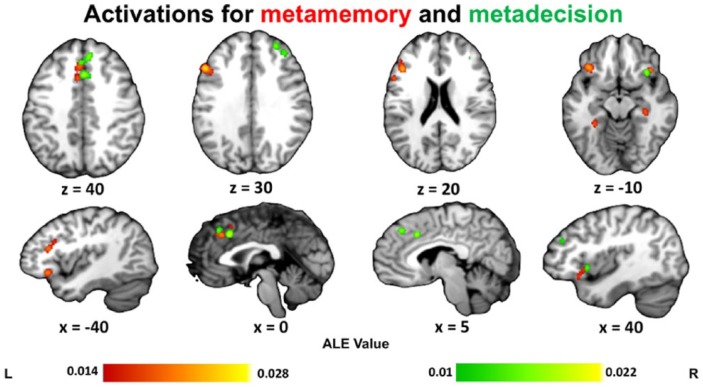
ALE results for all studies on metamemory (red) and metadecision (green).
Clusters are displayed in MNI standard space. Multiple-comparisons
correction was applied at the cluster level at a family-wise
error-corrected threshold of p < .05, 5000
permutations, and a cluster-defining threshold of
p < .001 uncorrected.